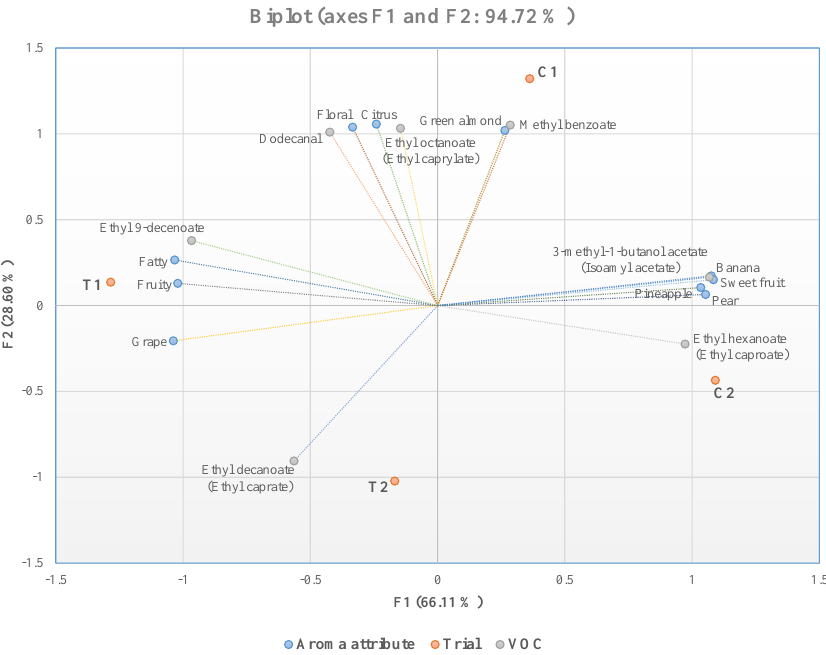
Figure 5. Principal component analysis (PCA) biplot for VOCs and aroma attributes. Abbreviations: T1, sequential inoculum with M. pulcherrima MP346/ S. cerevisiae SPF52; T2, glutathione-rich inactivated yeasts and sequential inoculum with M. pulcherrima MP346/ S. cerevisiae SPF52; C1, single inoculum with S. cerevisiae SPF52; C2, glutathione-rich inactivated yeasts and single inoculum with S. cerevisiae SPF52.